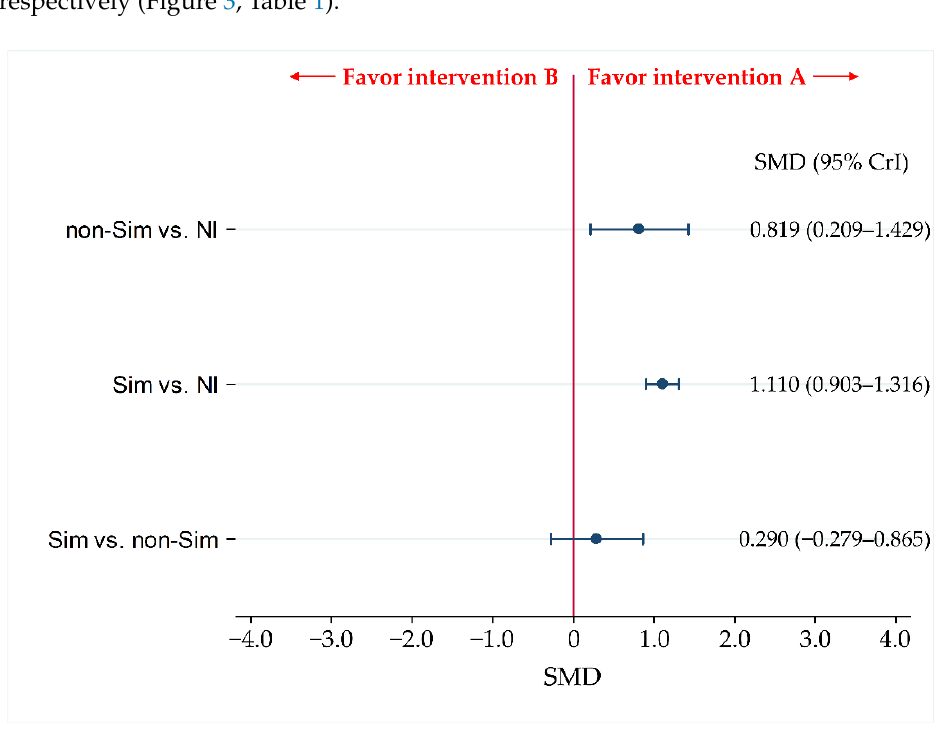
Figure 3. Comparison of the efficacy of knowledge scores for Sim, non-Sim, and no intervention. We expressed comparisons as intervention A vs. intervention B. Data were expressed as standardized mean differences (Std. MD) and 95% credible intervals (CrIs). Sim, simulation-based training; non-Sim, non-simulation-based training; NI, no educational intervention.